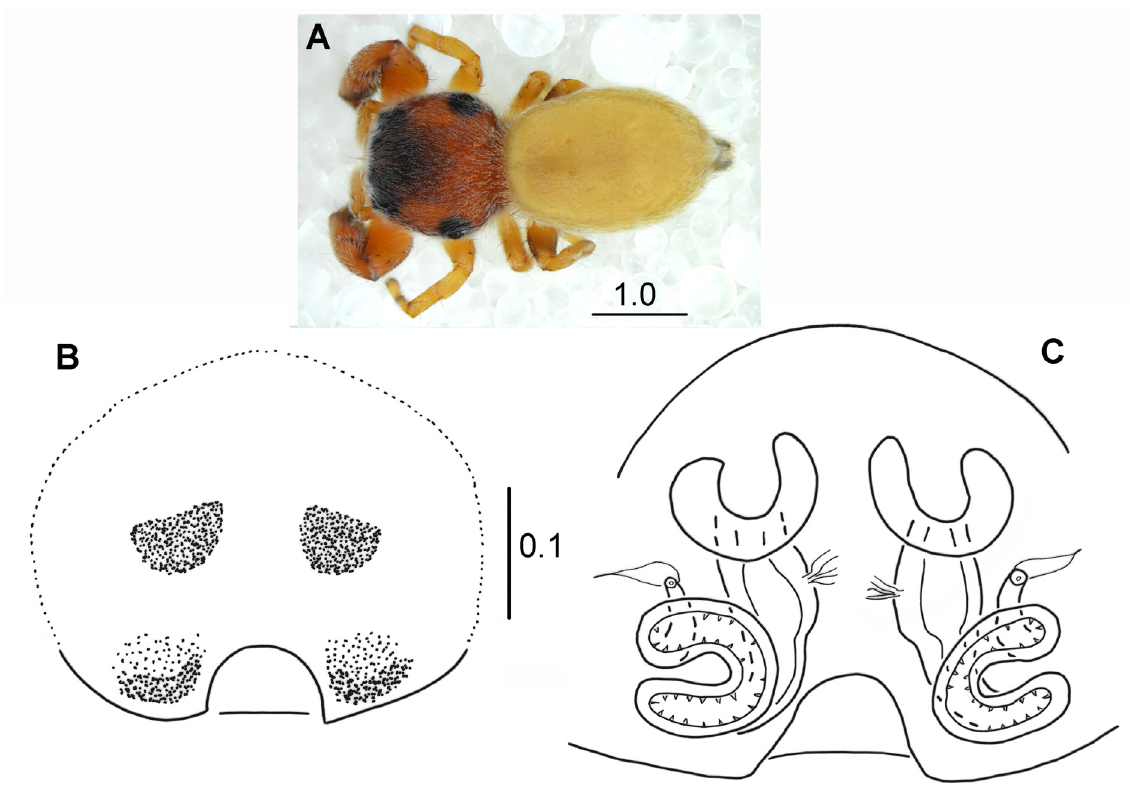
Fig. 58. Rhene ferkensis sp. nov., holotype, ♀ (MNHN). A . Habitus, dorsal view. B . Epigyne. C . Internal structure of